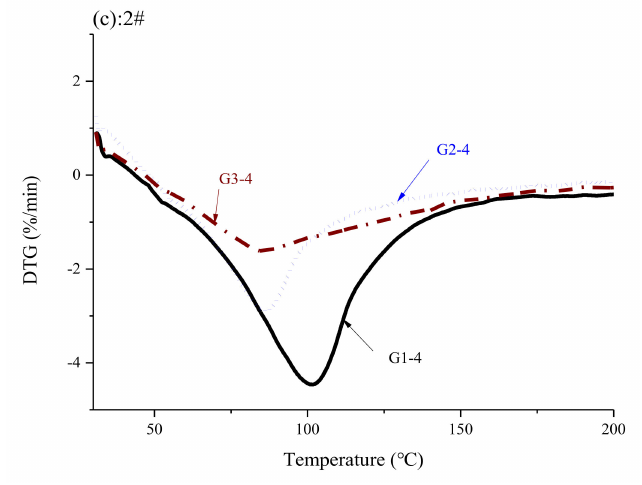
Figure 8. TG/DTG curves of samples cured for 28 d with different M/P ratios and 40 wt.% glass powder concentration, where ( a ) shows all curves and ( b , c ) are expanded graphs of areas 1 and 2 in ( a